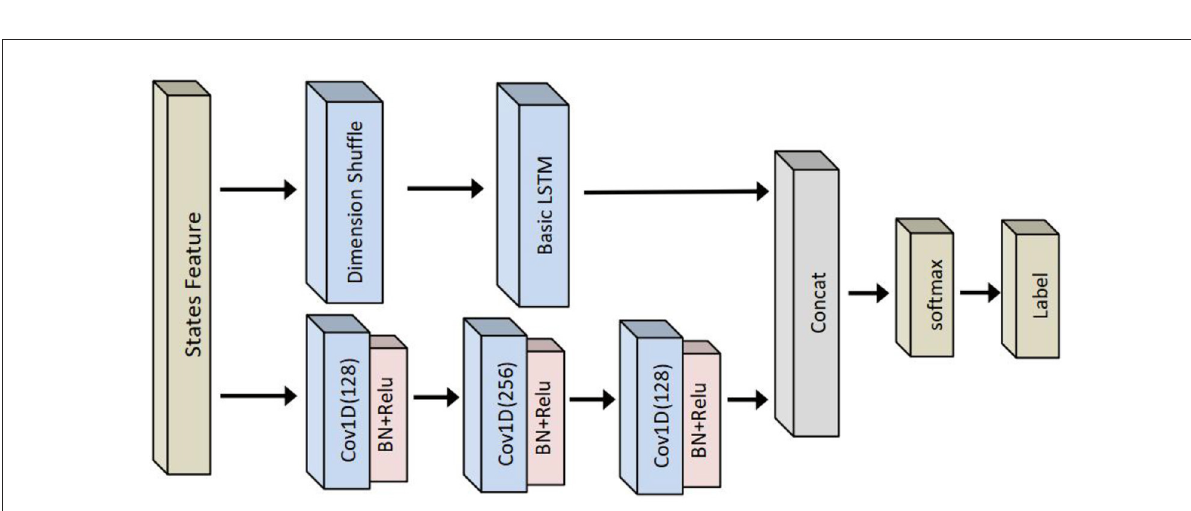
FIGURE7 LSTM fully convolutional network (FCN-) based human–robot collaborative grinding state classifier.